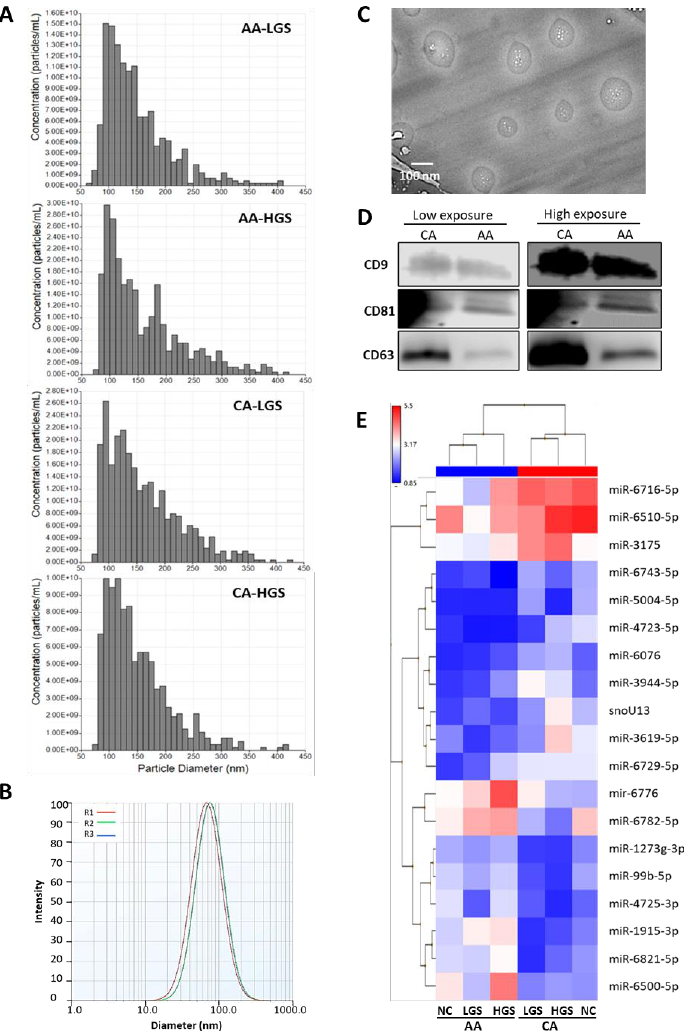
Figure 1. Characterization of small extracellular vesicles (sEVs) isolated from the plasma of PCa patients and miRs profiling of sEVs. ( A ): Characterization of sEVs isolated from blood samples of AA and CA PCa patients. The sizes of sEVs was measured by the qNano method at LGS and HGS of AA and CA patients. ( B ): Representative graph showing the size of sEVs measured by ZetaPALS analysis. ( C ): Cryo-TEM micrograph showing the diameter of sEVs. Scale bar is 100 nm. ( D ): Expression of surface protein markers (CD9, CD81 and CD63) of sEVs isolated from AA and CA PCa samples detected by Western blot analysis. Complete blots are available in Figure S1. ( E ): Microarray analysis of sEV-associated miRs collected from plasma of AA and CA PCa patients in addition to age- and race-matched normal subjects. Representative heatmap showing the upregulated (red) and downregulated (blue) sEV-associated miRs in AA versus CA PCa normalized to healthy volunteers. AA: African American; CA: Caucasian American; NC: Normal control subjects; HGS: high Gleason score; LGS: low GS; R1-3: number of repeats of